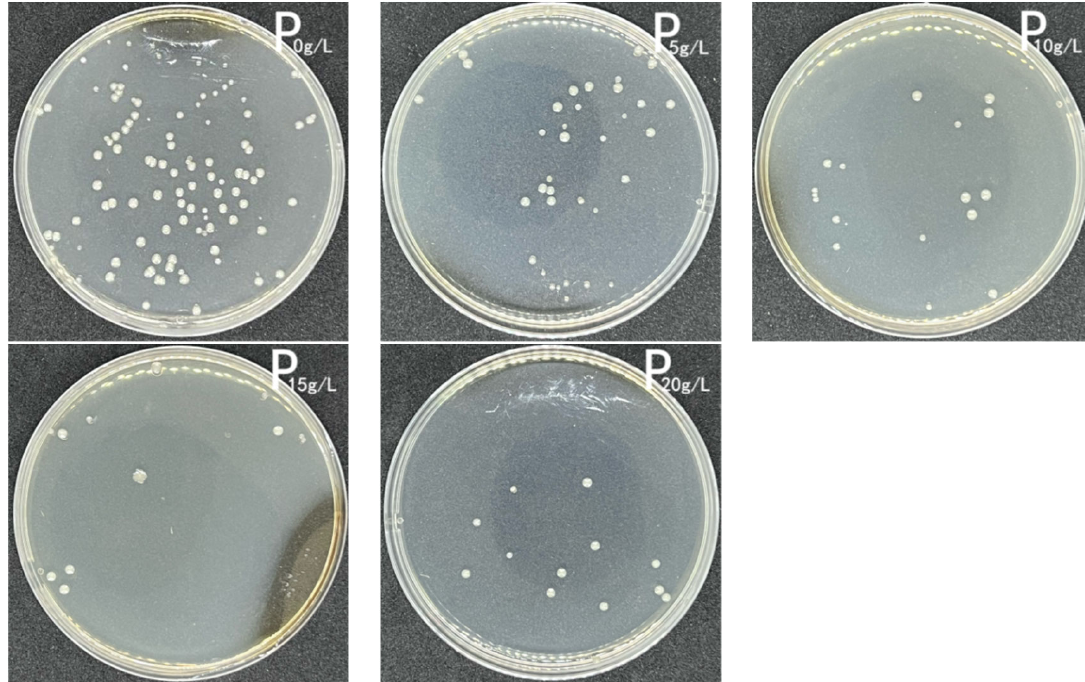
Figure 12. Inhibition of E. coli by untreated co tt on and antimicrobial co tt on.